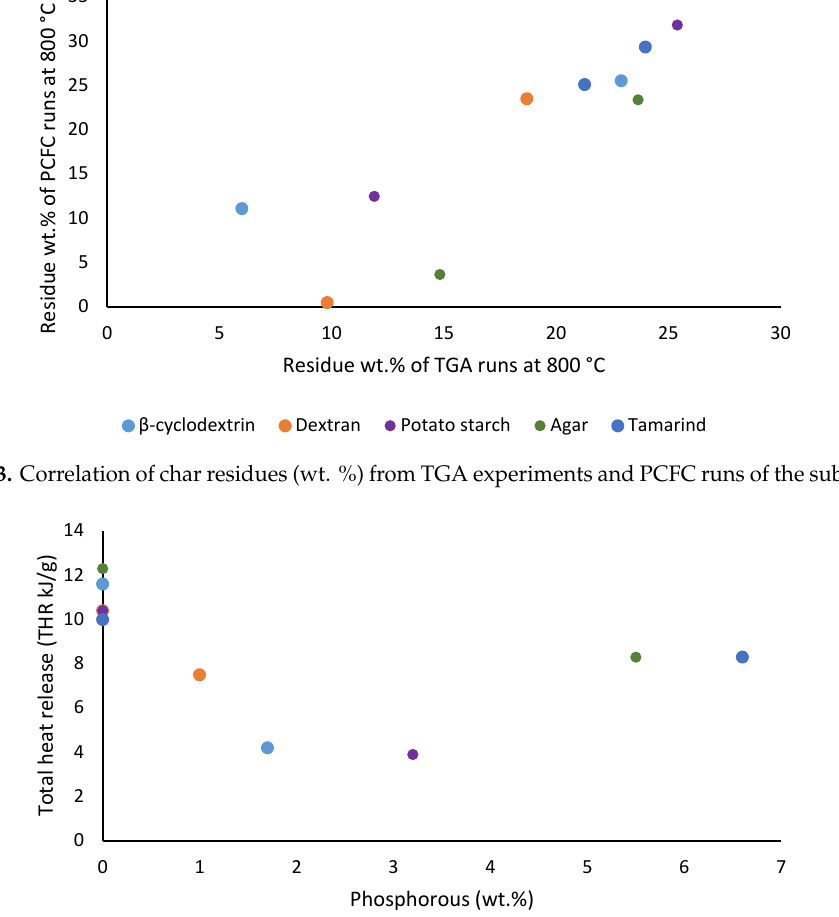
Figure 14. Plot of total heat release (THR) versus phosphorus content (wt. %) of the substrates.